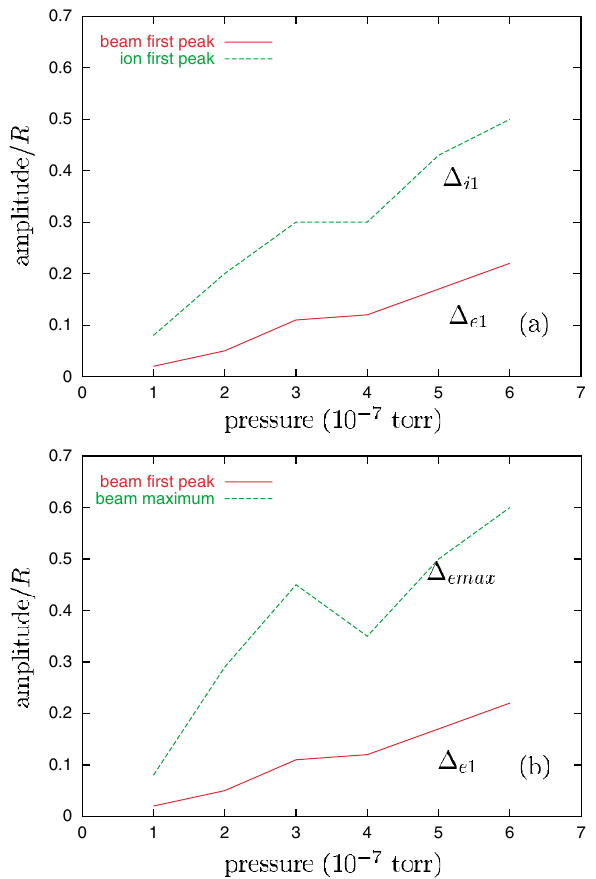
FIG. 11. (Color) Effect of ion-hose instability on beam radius FIG. 10. (Color) Peak beam and ion channel centroid displace- and emittance at the end of the accelerator from the LSP ments at the end of an accelerator from LSP . (a) shows the first simulations. (a) shows rms radius and (b) shows normalized ) and ions ( " ). (b) shows the nonlinear peak for the beam ( " emittance for pressures of 10 (cid:1) 7 and 6 (cid:3) 10 (cid:1) 7 torr . The red e 1 i 1 ) and maximum ( " ) peaks for the beam. first ( " lines show the values averaged over 50 e 1 e max